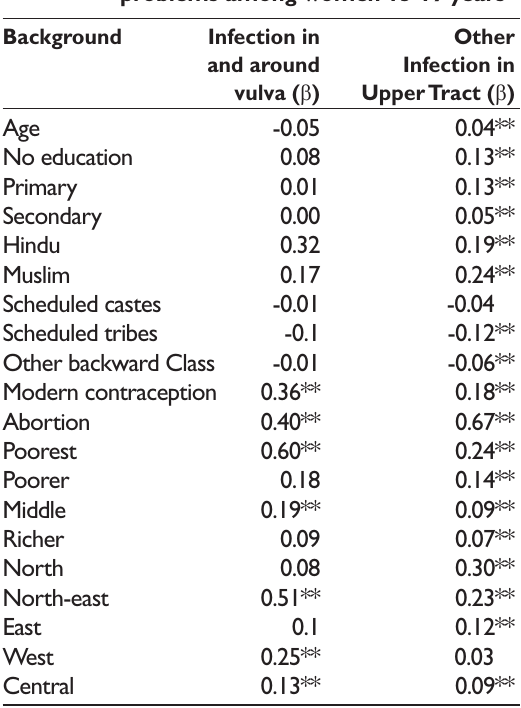
Linear regression showing beta values Infection in and around the vulva and other Infection in upper